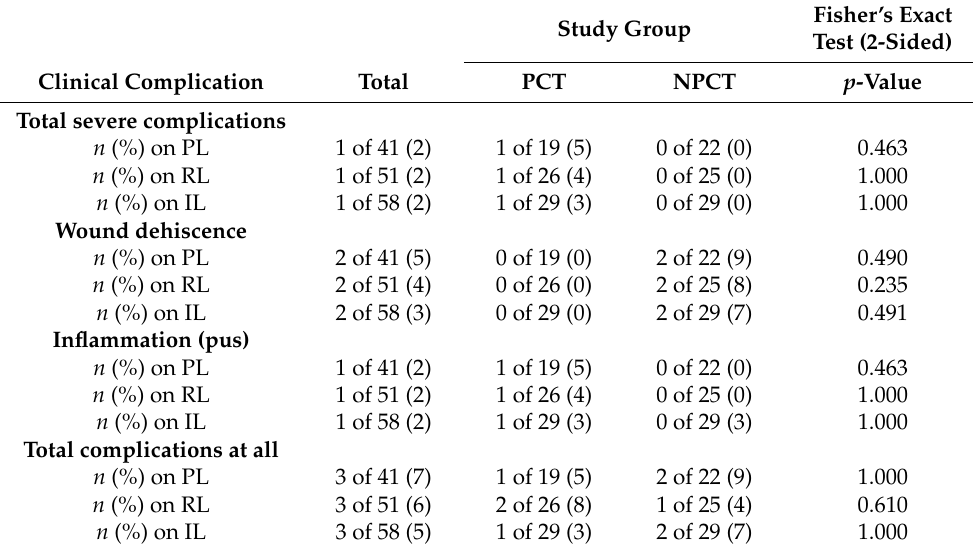
Table 2. Clinical complications on a patient, region, and implant